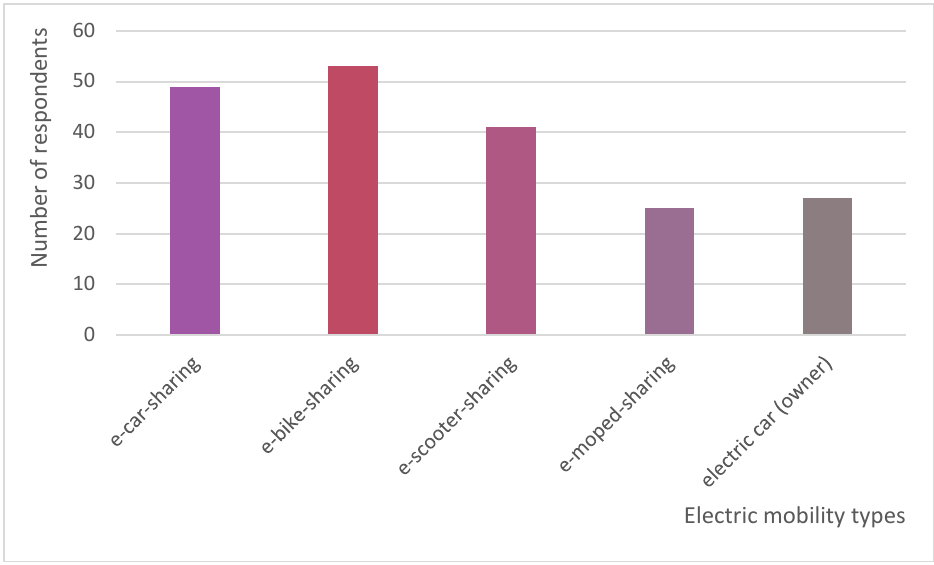
Figure 5. The preferred form of electric mobility.